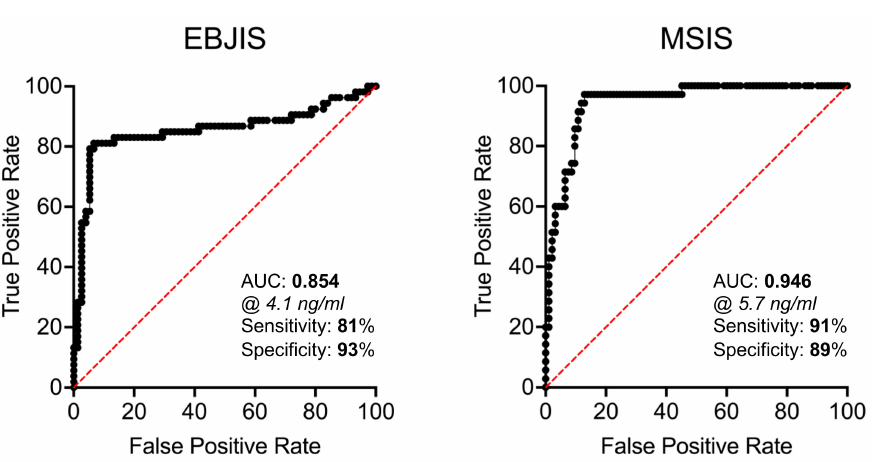
Figure 4. ROC curves of the concentration of PTX3 in the synovial fluid of THA and TKA patients with and without PJI (based on EBJIS and MSIS